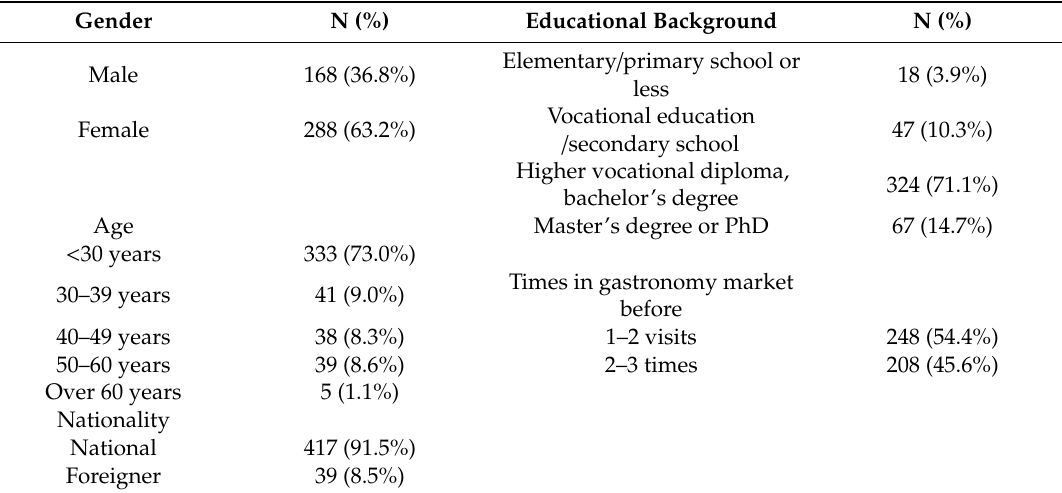
Table 2. Socio-demographic profile.